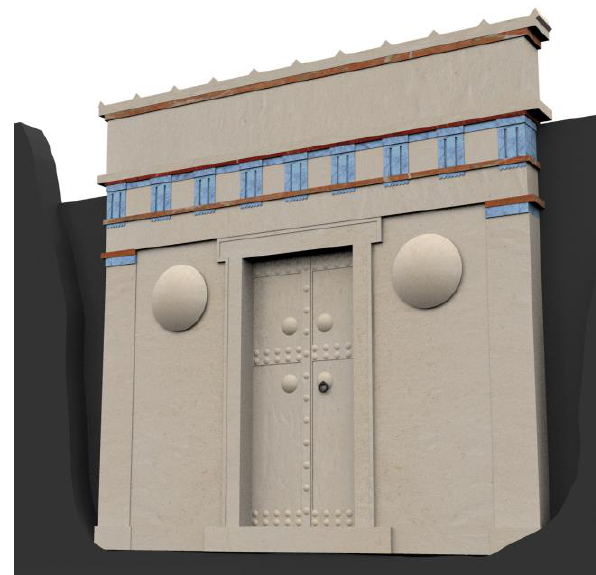
Figure 29. The Tomb of Alexander IV in Verghina. View from the east. Detail of the 3D